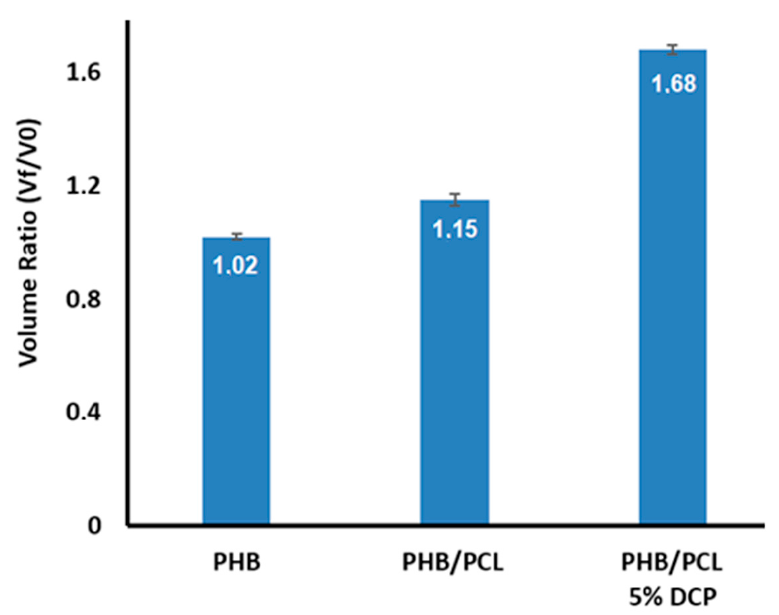
Figure 5. Volume ratio variation of PHB, PCL and PHC/PCL (60/40)-5DCP samples after 2 days of immersion in THF.